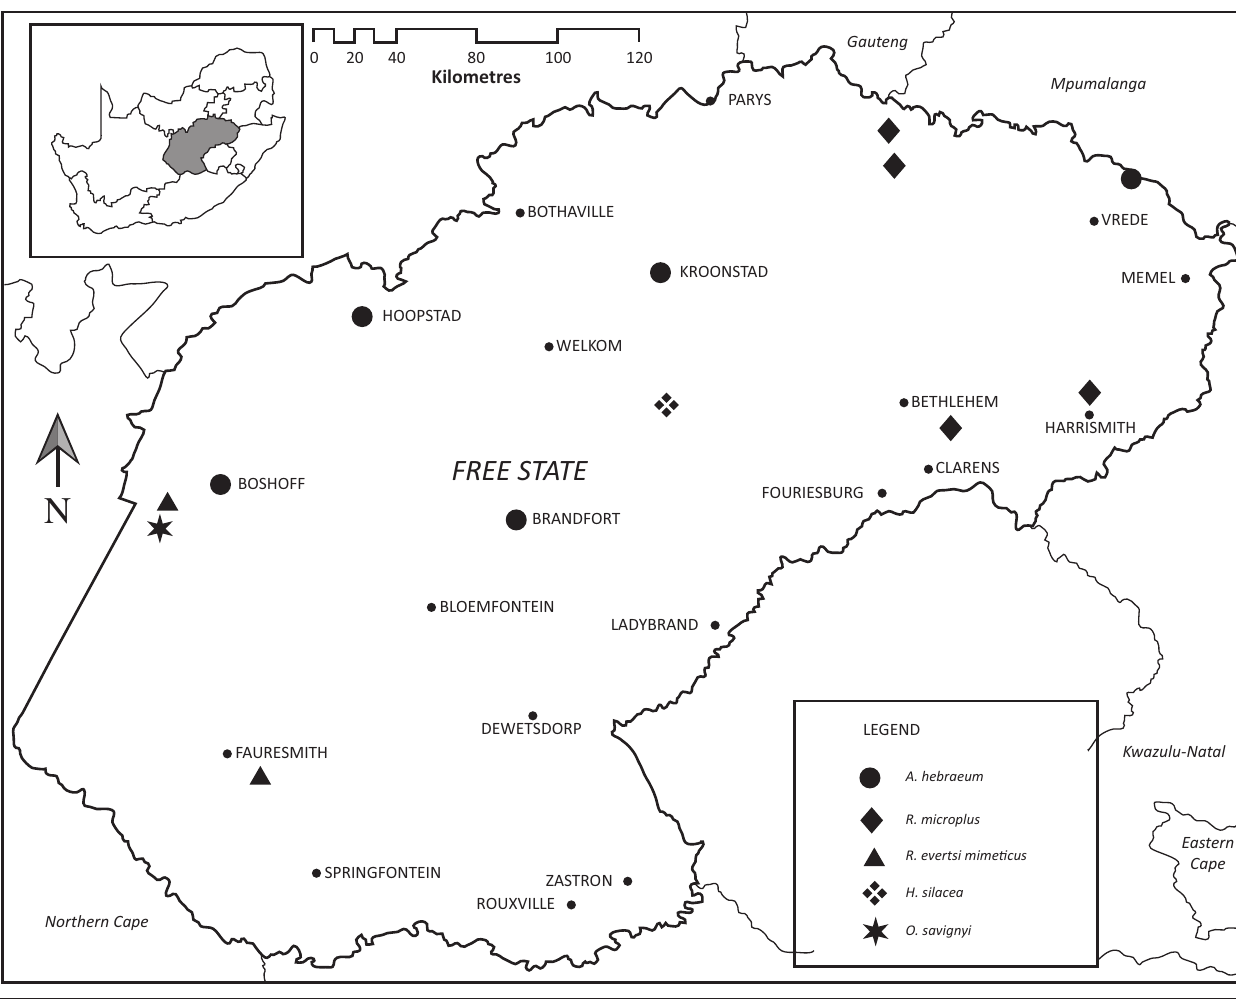
FIGURE 3: Localities at which the ticks Amblyomma hebraeum , Rhipicephalus microplus , Rhipicephalus evertsi mimeticus , Haemaphysalis silacea and Ornithodoros savignyi were collected in Free State Province, South